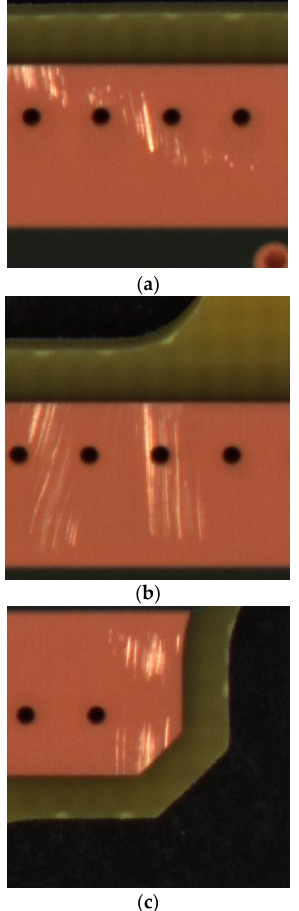
Figure 6. False negative PCB sections: ( a ) False negative sample 1. ( b ) False negative sample 2. ( c ) False negative sample 3. Electronics 2020 , 9 , x FOR PEER REVIEW